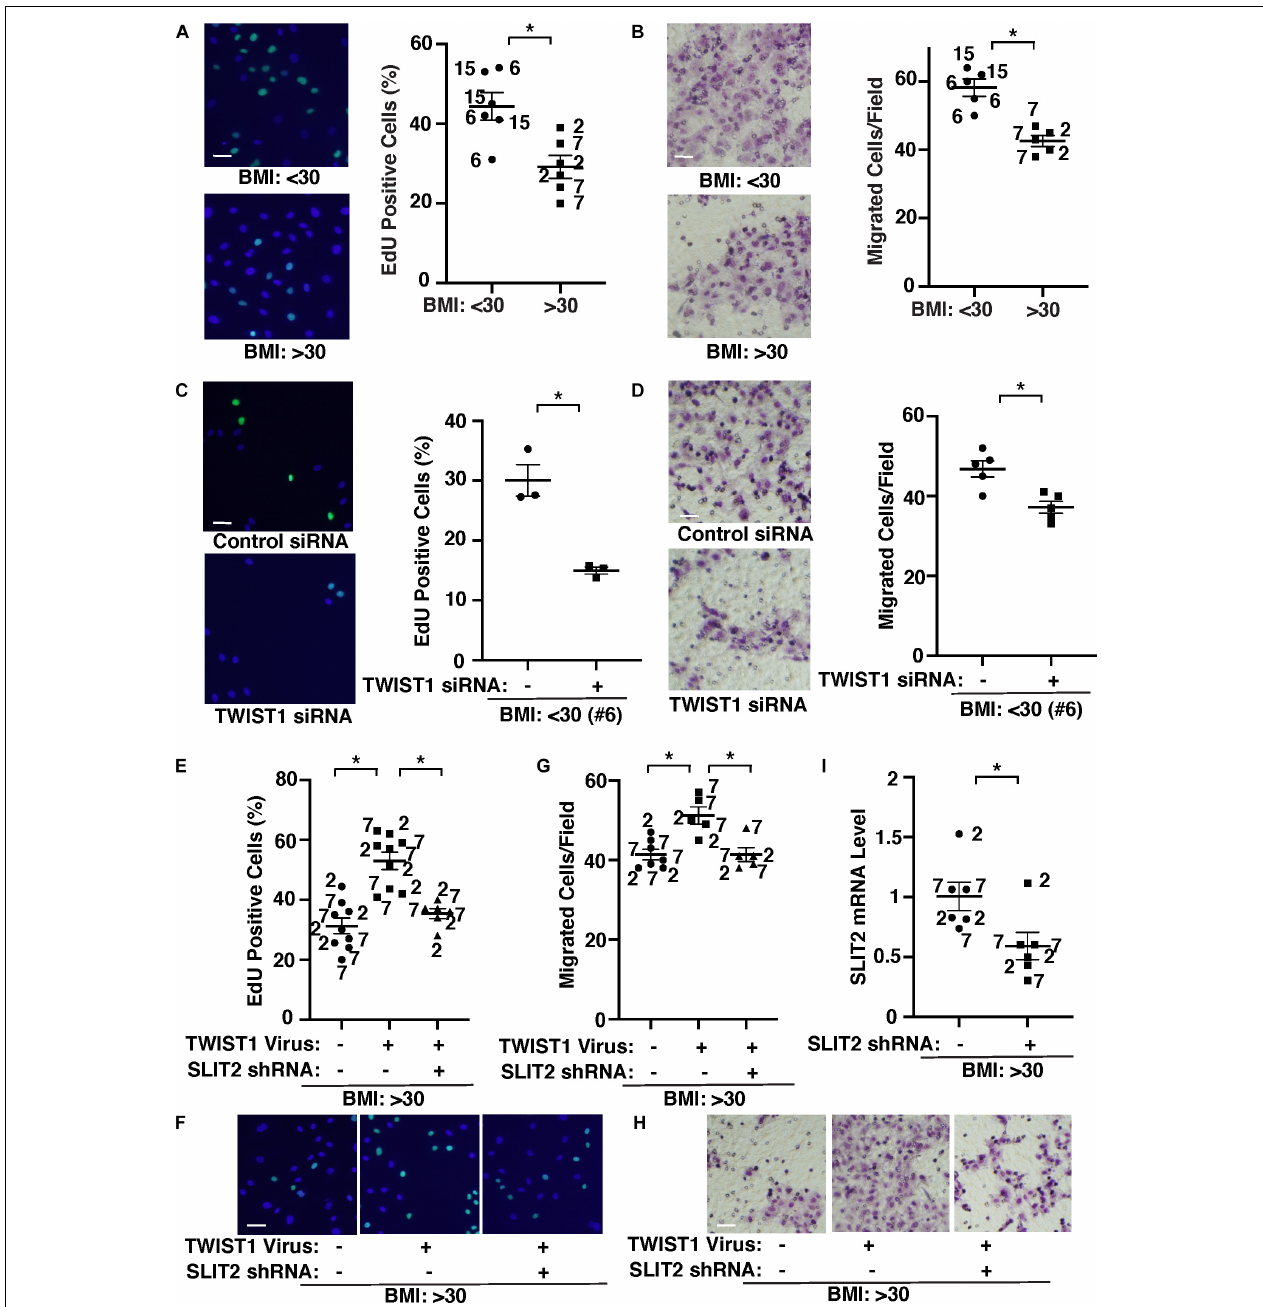
FIGURE 3 | TWIST1-SLIT2 signaling controls DNA synthesis and EC migration in lean vs. obese human adipose ECs. (A) Representative images showing EdU positive (green) lean (BMI < 30) vs. obese (BMI > 30) human adipose ECs ( left ). Scale bar, 50 µ m. Graph showing DNA synthesis of lean (BMI < 30) vs. obese (BMI > 30) human adipose ECs analyzed using an EdU staining assay ( right , n = 6, mean ± SEM, * p < 0.05). (B) Representative images showing lean (BMI < 30) vs. obese (BMI > 30) human adipose ECs migrated to the opposite side of the trans -well membrane and stained with Wright Giemsa solution ( left ). Scale bar, 50 µ m. Graph showing lean vs. obese human adipose ECs migrating toward 5% FBS ( right , n = 5, mean ± SEM, * p < 0.05). (C) Representative images showing EdU positive (green) lean (BMI < 30) human adipose ECs treated with TWIST1 siRNA ( left ). Scale bar, 50 µ m. Graph showing EdU-positive lean (BMI < 30) human adipose ECs (clone #6) treated with TWIST1 siRNA ( right , n = 3, mean ± SEM, * p < 0.05). As a control, human adipose ECs were treated with siRNA with irrelevant sequences. (D) Representative images showing lean (BMI < 30) human adipose ECs treated with TWIST1 siRNA, migrated to the opposite side of the trans-well membrane and stained with Wright Giemsa solution ( left ). Scale bar, 50 µ m. Graph showing lean human adipose ECs (clone #6) treated with TWIST1 siRNA migrating toward 5% FBS ( right , n = 5, mean ± SEM, * p < 0.05). As a control, human adipose ECs were treated with siRNA with irrelevant sequences. (E) Graph showing EdU-positive obese (BMI > 30) human adipose ECs treated with lentivirus overexpressing TWIST1 or in combination with SLIT2 shRNA ( n = 6–9,